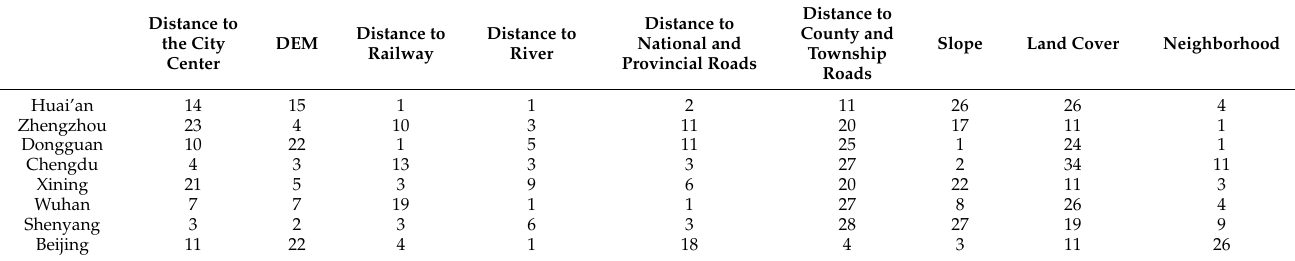
Table A1. Weights used in the LUSD-urban model and the trend-adjusted neighborhood